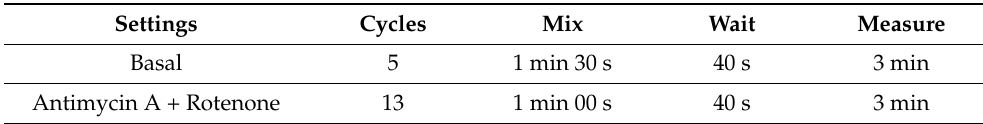
Table A1. Parameters of XF24 Seahorse used to measure O 2 concentration, oxygen consumption rate (OCR), and extracellular acidification rate